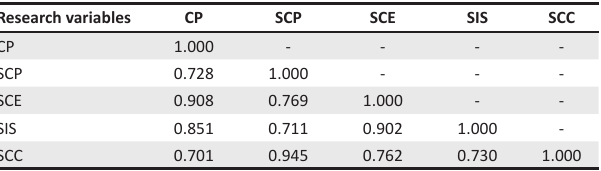
TABLE 3: Correlations matrix.